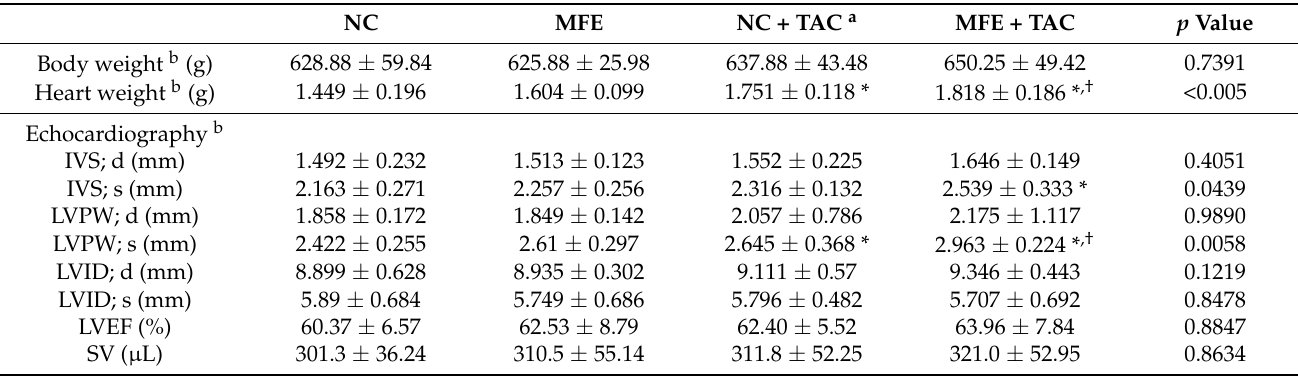
Table 1. Body weight, heart weight, and echocardiographic characteristics of offspring with maternal fructose exposure and ventricular pressure